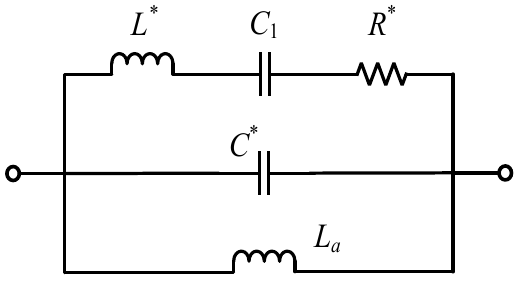
Figure 6. The equivalent circuit for an in-liquid QCM after the addition of inductance L a . Using Group 5 in Table 1 as an example, the S21 parameters vs. frequency curve after added the inductance L a is shown in Figure 7. By comparing Figures 5 and 7, it was clear that the addition of L a with a value of 29.8 µ H, the resonance frequency change caused by the added resistance decreased from 2534 Hz to 9 Hz. Furthermore, resonance damping also